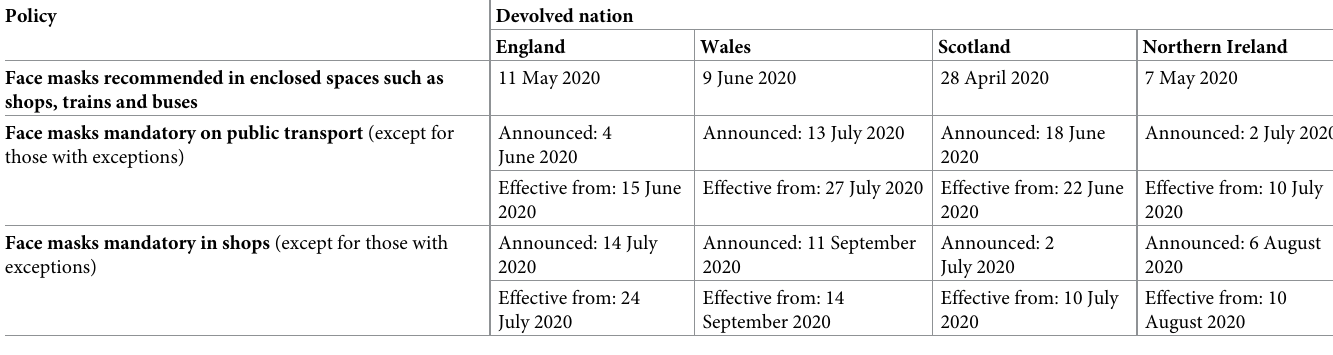
Table 1. Guidelines and policy changes for face mask use in the UK’s devolved nations during 2020. Policy Face masks recommended in enclosed spaces such as shops, trains and